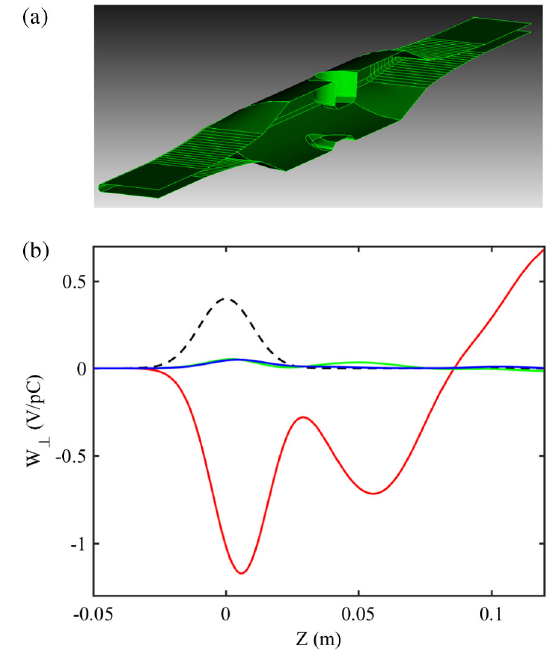
FIG. 5. (a) CUBIT half model of the scrapers, including artificial tapers, with top scraper inserted and bottom scraper retracted. (b) Transverse wakes of the asymmetric scrapers: monopole (red), dipole (green), and quadrupolar (blue) term. The dipole and quadrupolar terms have been multiplied by a factor of Δ y ¼ 0 . 5 mm to compare with the transverse monopole term. Dashed line: bunch distribution ( σ z ¼ 10